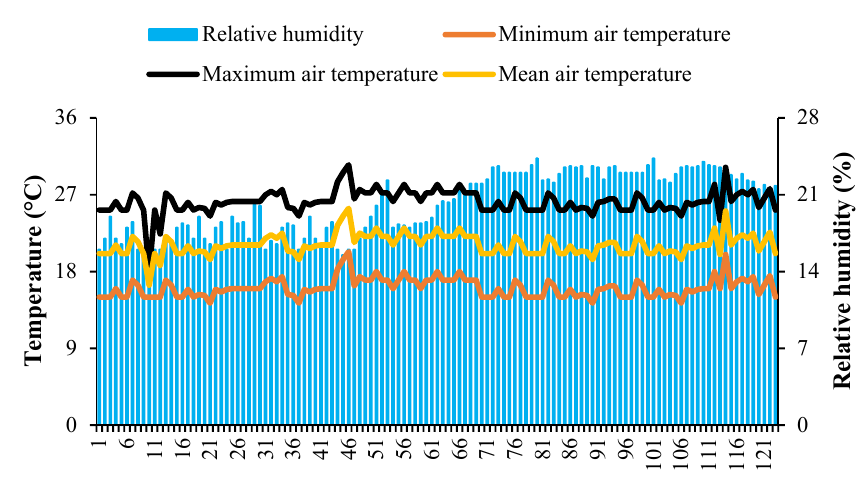
Figure 1. Microclimate conditions inside the greenhouse during the experiment (16 July to 15 November 2020) at research station of University of Agriculture, Faisalabad, Punjab, Pakistan.